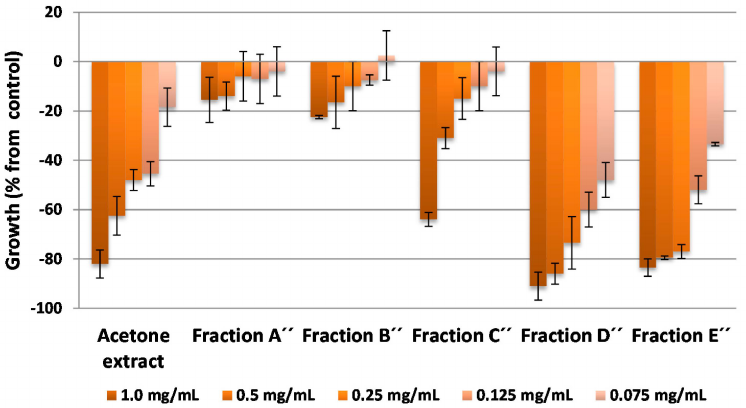
Figure 5. Bioactivities obtained in the etiolated wheat coleoptile bioassay for the acetone extract and the fractions obtained by chromatography from citrus waste of Citrus sinensis. Values are expressed as percentage difference from